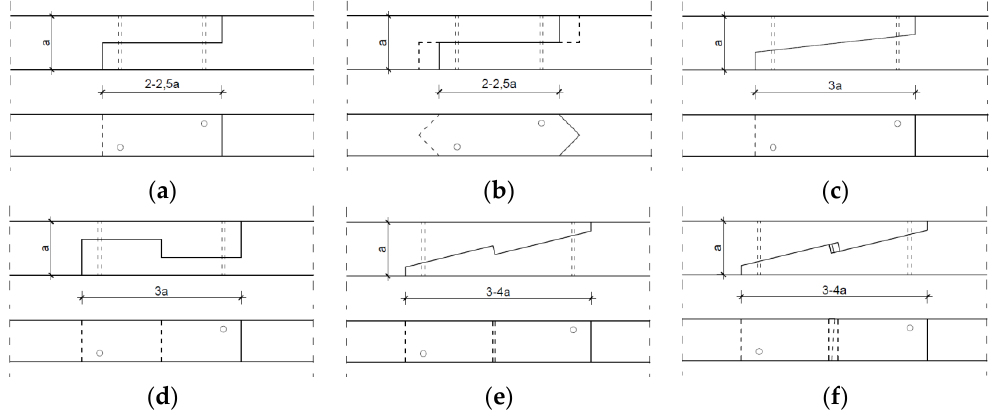
Figure 1. Various forms of scarf and splice joints: ( a ) splice joint, ( b ) nibbed splice joint, ( c ) nibbed scarf joint, ( d ) tabled splice joint, ( e ) stop-splayed scarf joint ( ‘ Bolt of lightning ’ ), ( f ) stop-splayed and tabled scarf joint with key.